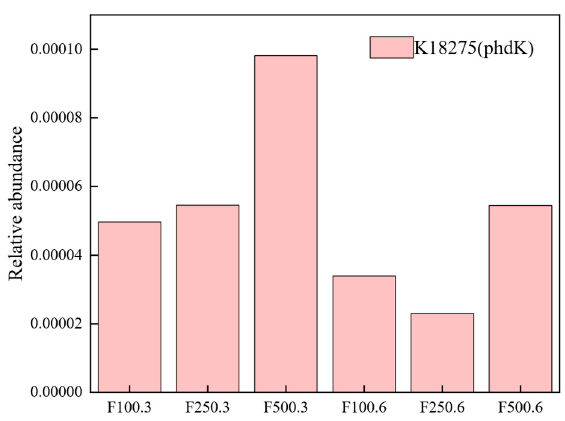
Figure 4. Relative abundance of some functional genes in the PHE degradation pathway.